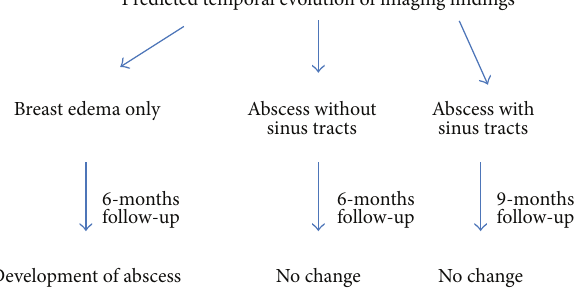
Figure 10: Flow chart representing the predicted temporal course of 3 subgroups.